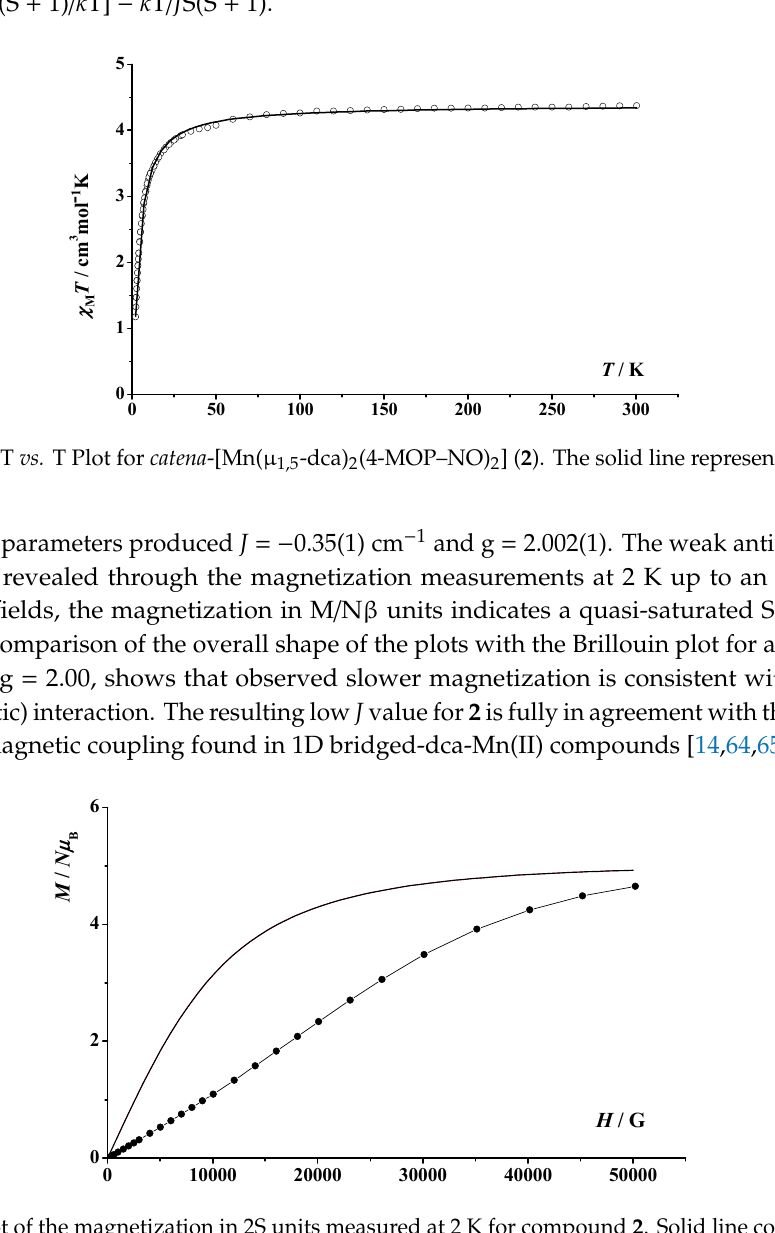
Figure 8. Plot of the magnetization in 2S units measured at 2 K for compound 2 . Solid line corresponds to the Brillouin function for fully isolated S = 5/2 system, g = 2.00.